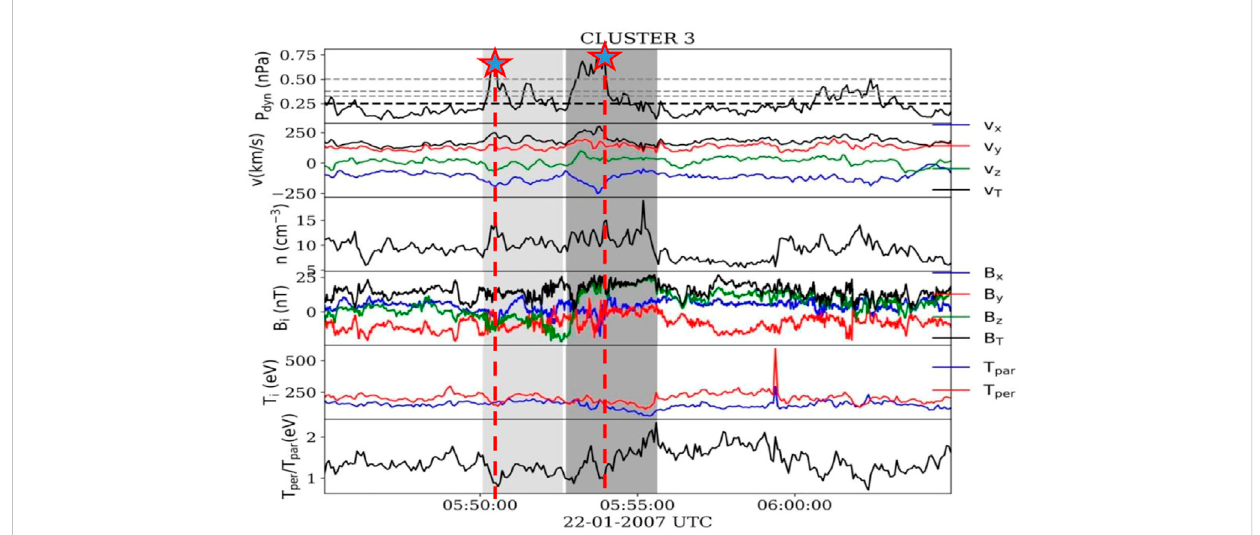
FIGURE 1 An example of Cluster 3 data illustrating two jets detected with the procedure described in the text. The panels show, from top to bottom, the dynamicalpressure, p dyn , thethreecomponentsoftheionbulkvelocityandthetotalspeed,thenumberdensity, n ,thethreecomponentsofthemagnetic fi eld and the magnetic fi eld intensity, the parallel and perpendicular temperature, the temperature anisotropy. The shaded areas indicate the two jets detected at 05:50:00 UT and 05:53:10 UT, respectively. The thin dashed lines represent the average value of the dynamic pressure computed over the 20 min of data showed in the fi gure and multiplied by N = 1.3, N = 1.5, N = 1.7, N = 2.The thick dashed line indicate the average value of the dynamic pressure. The two stars mark the maximum of the dynamic pressure and the vertical red dashed lines mark the time when this maximum is